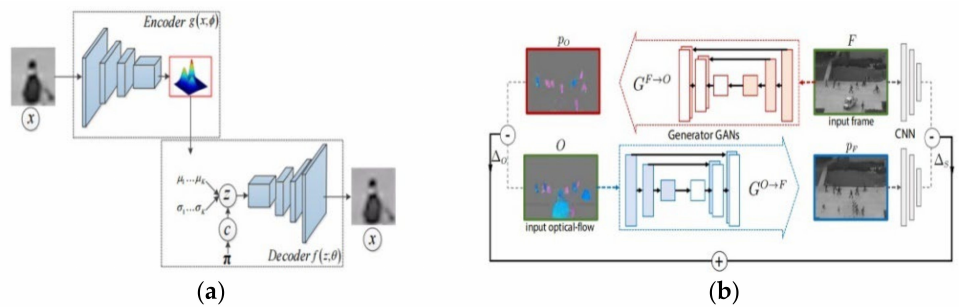
Figure 2. Examples of the deep learning-based method. ( a ) GMFC-VAE [32]. ( b ) GAN